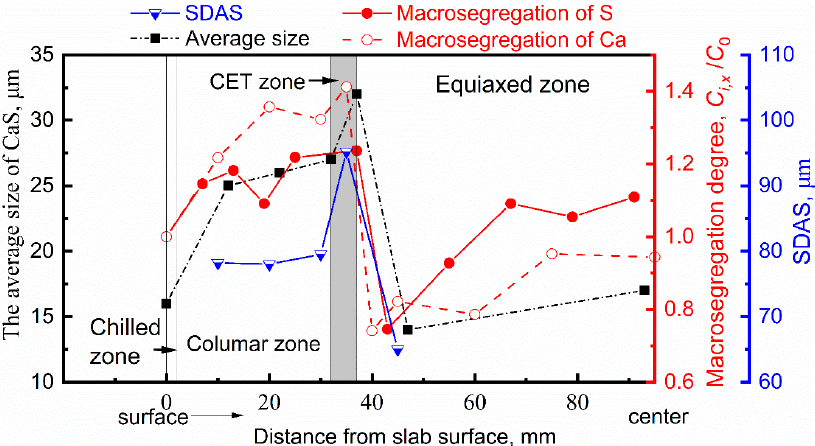
Figure 9. The size distribution of CaS inclusions and macrosegregation degree of S along the thickness of casting slab. The macrosegregation degree was defined by the ratio of concentration of solute at the x mm position from surface ( C i,x ) to initial liquid concentration ( C 0 ).